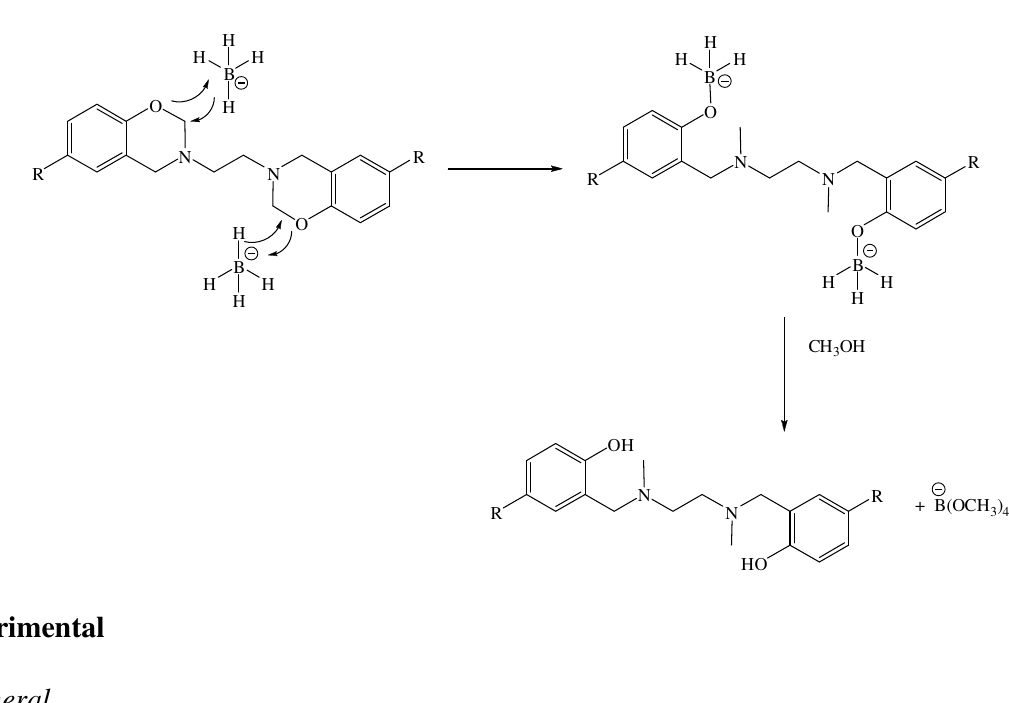
Scheme 2. Mechanism of reduction of 5a-h with NaBH